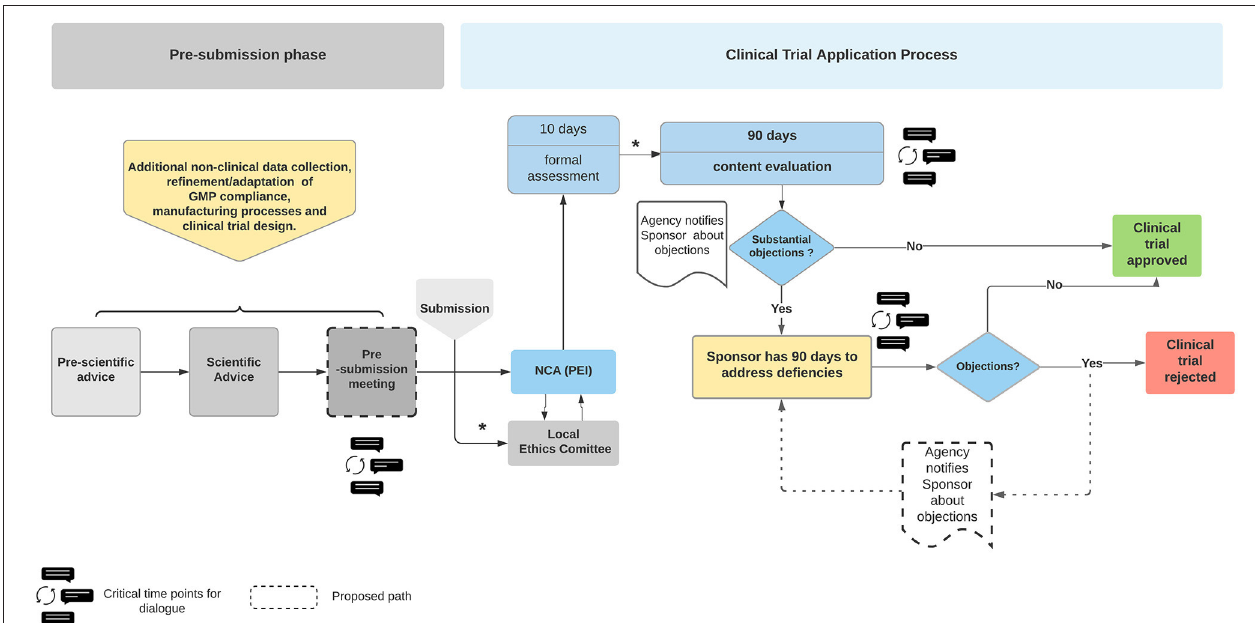
FIGURE 1 | Overview of the Clinical Trial Application process for ATMPs in Germany. The Sponsor has opportunity to seek advice from the National Competent Authority (NCA), Paul Ehrlich Institute (PEI). The Sponsor is notified of the regulators’ concerns at the first review discussions following formal submission. The Sponsor has 90 days to address the issues raised. The clinical trial is rejected if the regulatory body is not satisfied with the responses. The dialogue bubbles indicate the proposed timepoints for a dialogue between the regulators and sponsors. The process describes the current legislative process. The timelines may differ once the Clinical Trial Regulation EU No 536/2014 is enacted in January 2022. The boxes with dashed lines are Authors’ suggestions in how to create a more dynamic dialogue, optimizing the outcome in favor of safer therapies which are available more rapidly. Blue boxes, PEI related actions; Yellow boxes, sponsor related actions. *Communication between Ethics Committee and Sponsor and intermediate steps regarding formal assessment during the CTA process are not depicted (not relevant in this context). NCA, national competent